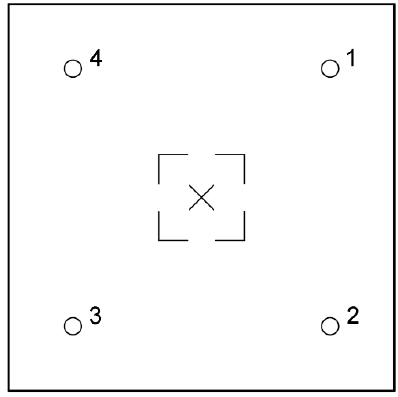
Table 3. Integral and RMS of frequency spectrum, void below impactor. Sensor N°